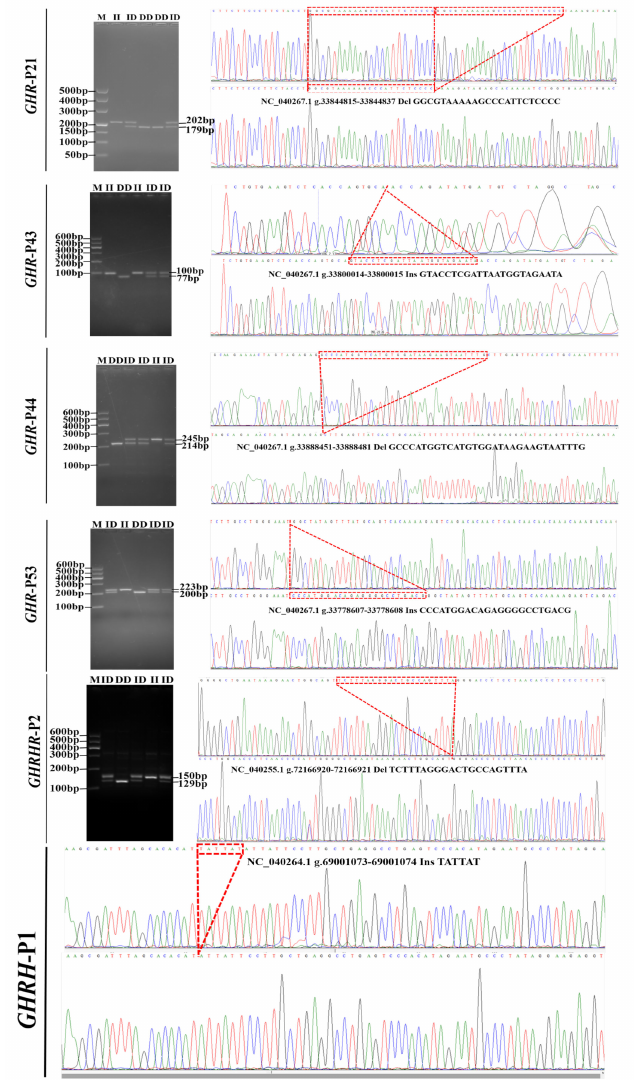
Figure 1. The electrophoresis diagram and sequence diagrams of six loci in GHR , GHRH, and